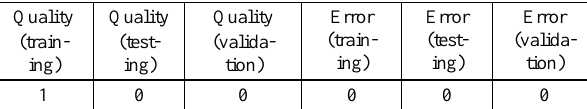
Fig. 4. Histogram of activation Table 6. List of qualities and errors of the regression model